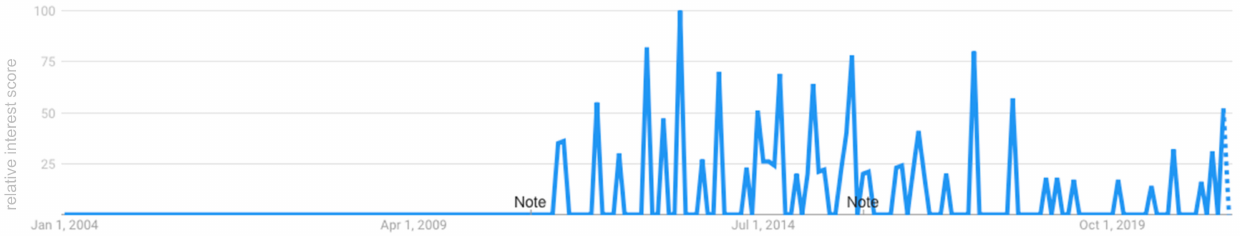
Figure 3. Interest over time results for ‘Inteligentne liczniki’ (in English: ‘Smart Meters’) over 2004—July